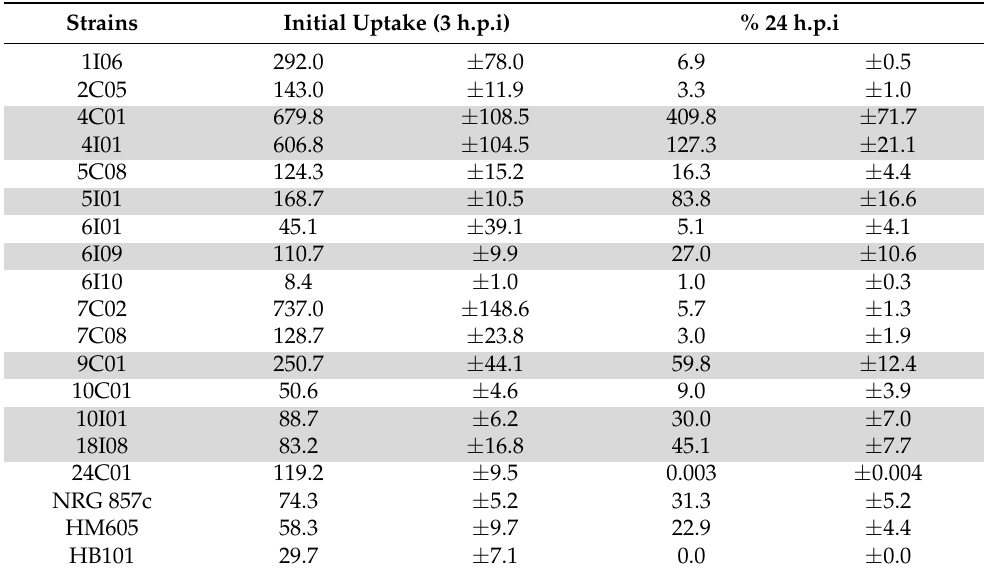
Table 2. Ability of E. coli strains to survive within RAW 264.7 macrophages *. Strains Initial Uptake (3 h.p.i) % 24 h.p.i 1I06